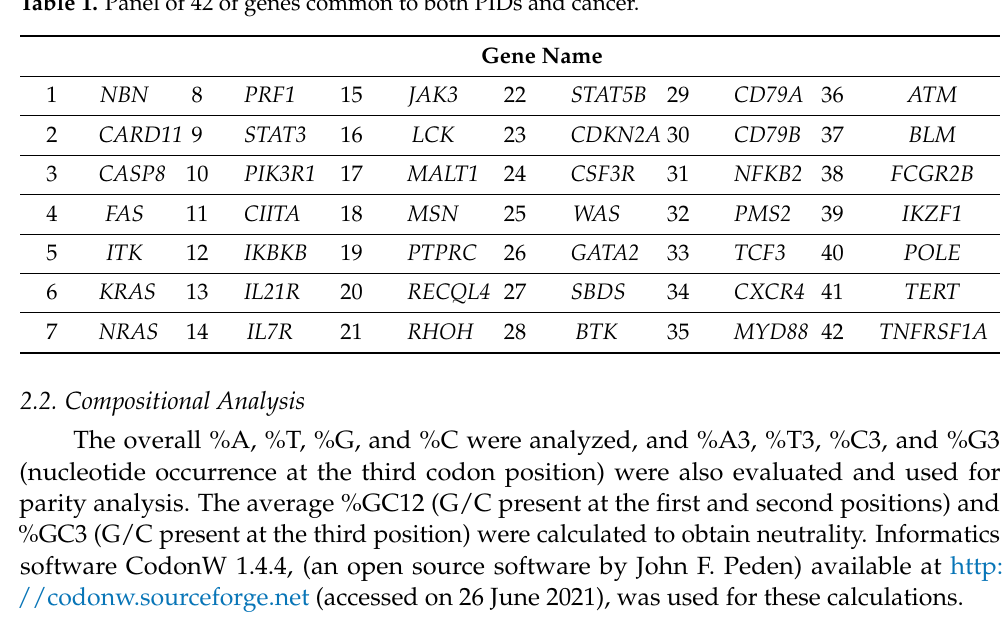
Table 1. Panel of 42 of genes common to both PIDs and